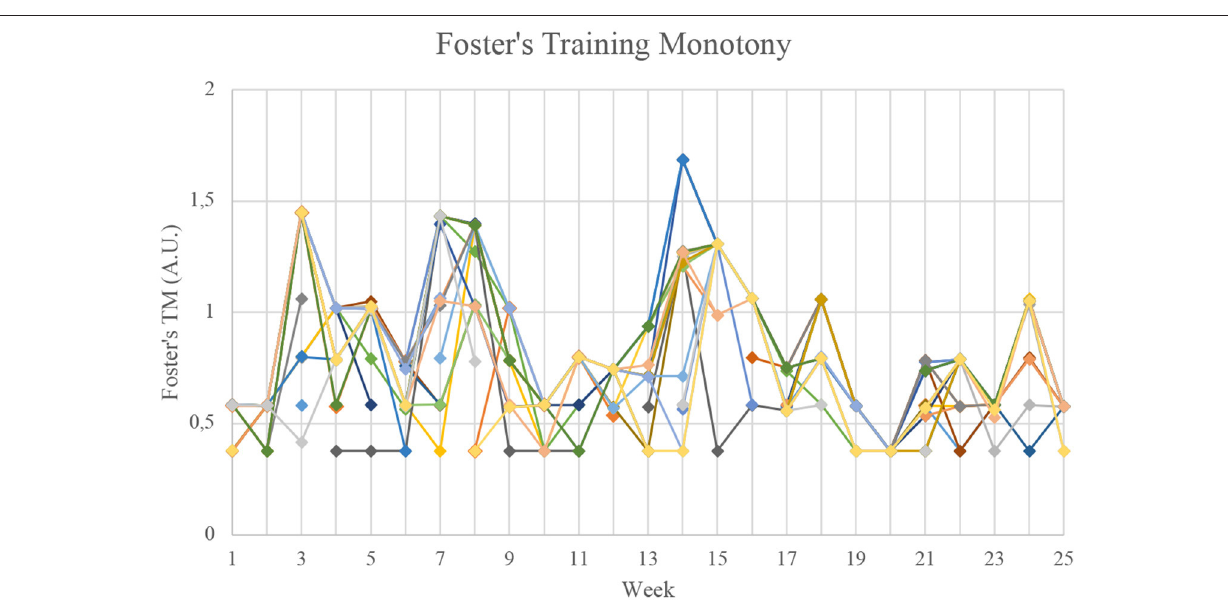
FIGURE 4 | Individual values for Foster’s Training Monotony. A.U., Arbitrary